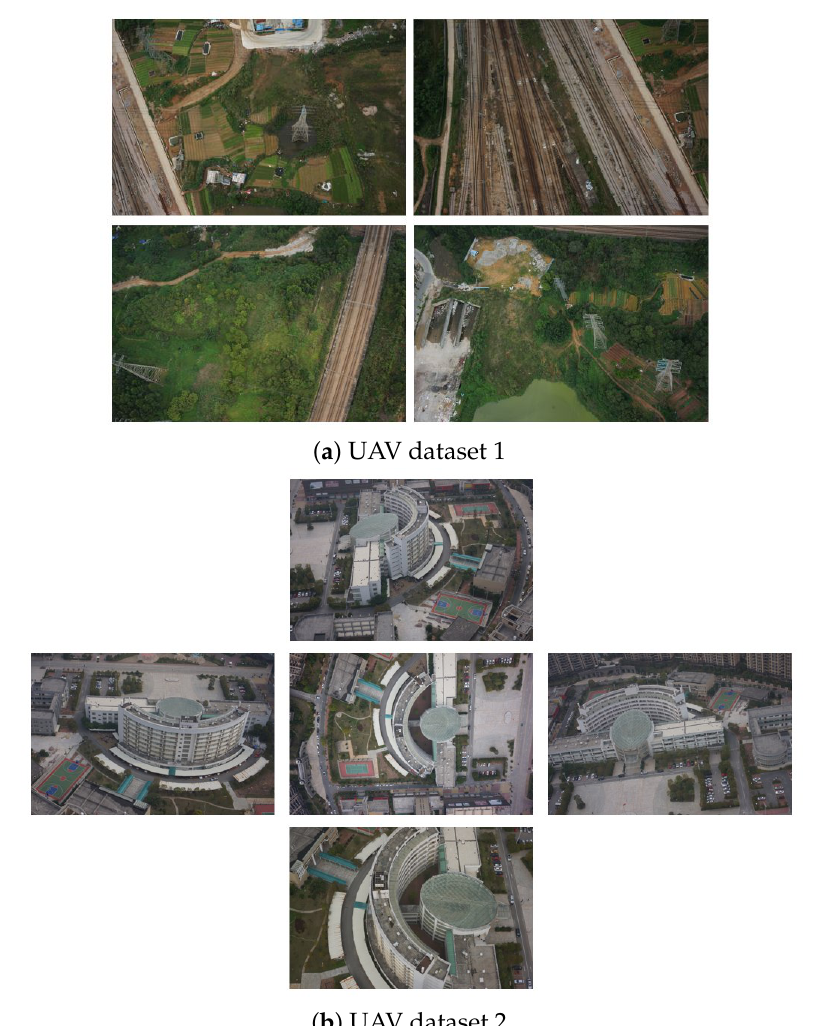
Figure 7. The illustration of these two UAV